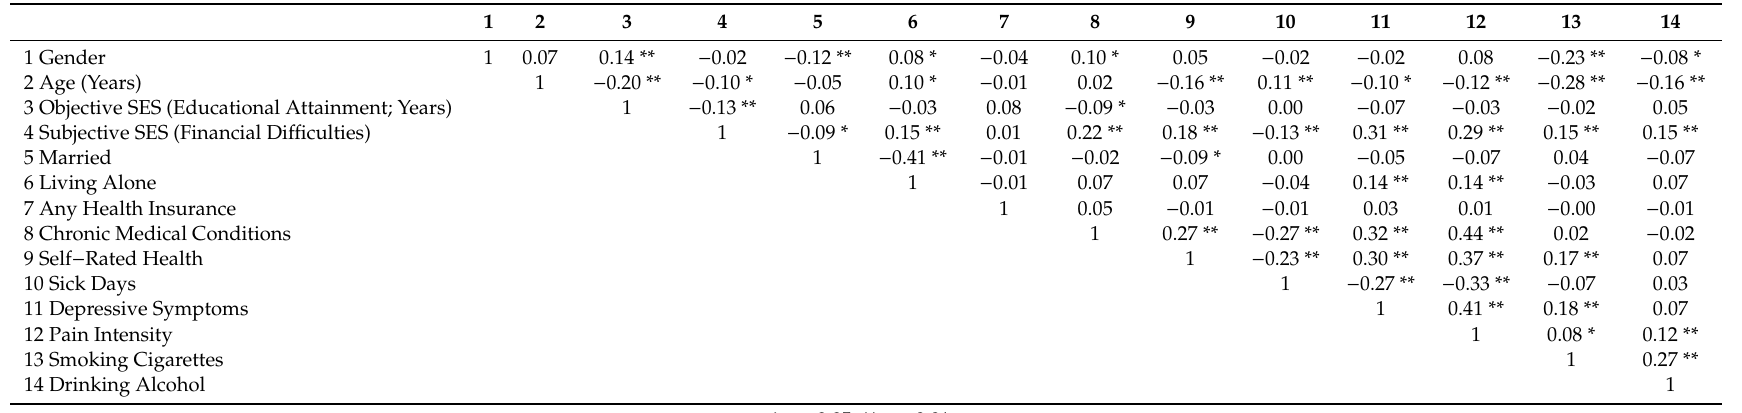
Table 2. Bivariate correlations.